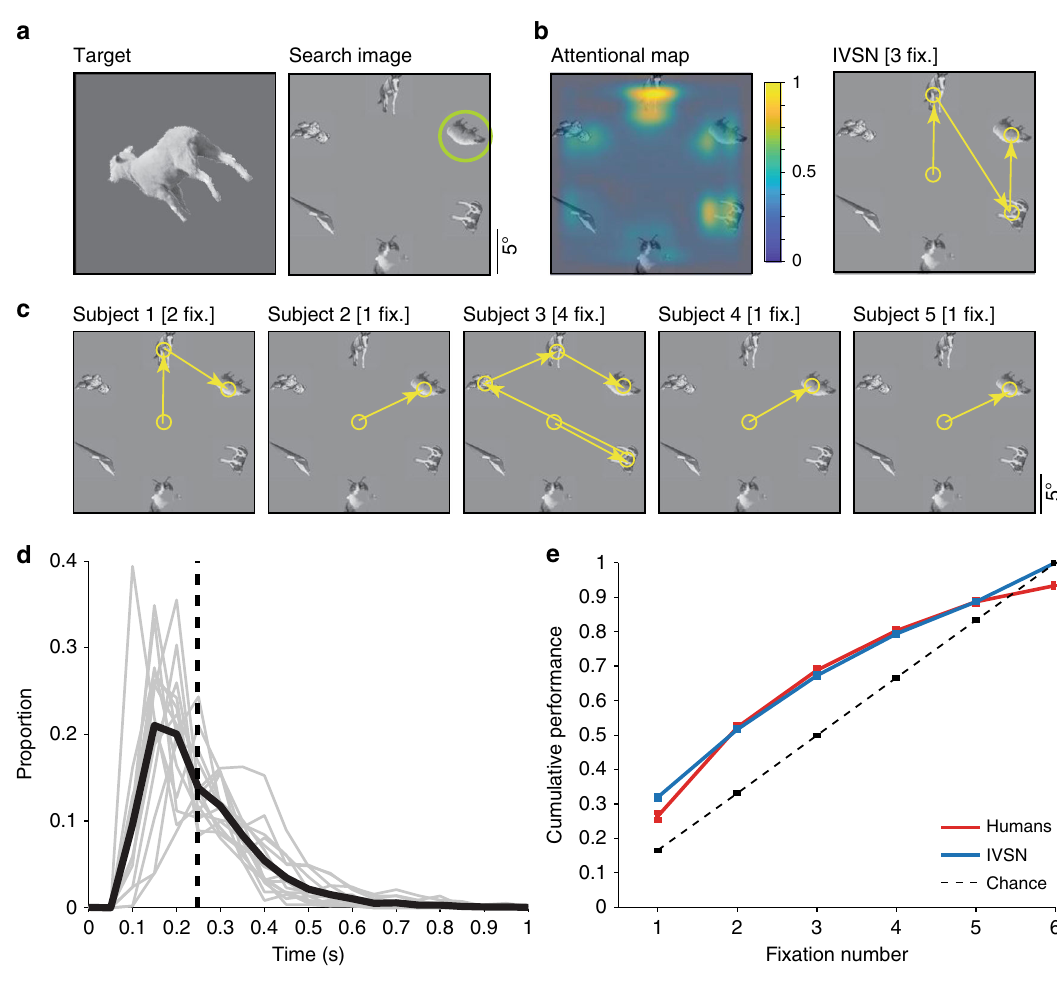
Fig. 3 Experiment 1 (Object arrays). a Example target and search images for one trial. The green circle showing the target position was not shown during the actual experiment. Due to copyright, the picture of a sheep in the target image is not the actual one used in this experiment. b Attentional map overlaid on the search image and sequence of fi xations for the IVSN model. c Sequence of fi xations for 5 subjects (out of 15 subjects). The number above each subplot shows the number of fi xations when the target was found. d Distribution of reaction times for the fi rst fi xation (see Supplementary Figure 2 for the corresponding distributions for subsequent fi xations). Gray lines show the reaction time distributions for 5 individual subjects, the black line shows the average distribution. The median reaction time was 248ms (SD = 130 ms, vertical dashed line). e Cumulative performance as a function of fi xation number for humans (red), IVSN oracle model (blue), and chance model (dashed line). Error bars denote SEM, n = 15 subjects (see Supplementary Figure 4